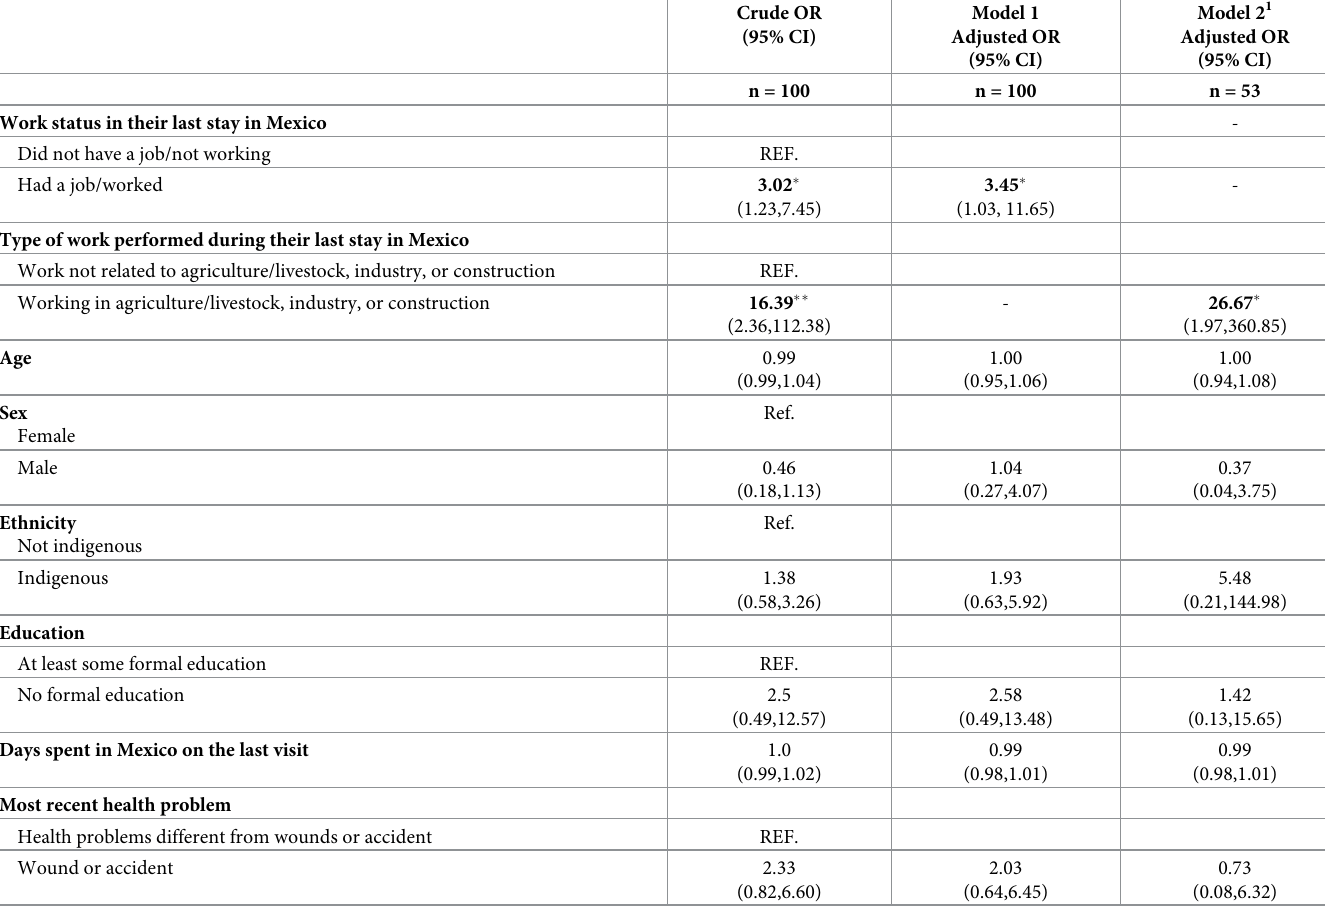
Table 4. Factors associated with cross-border use of health services by Guatemalans living in